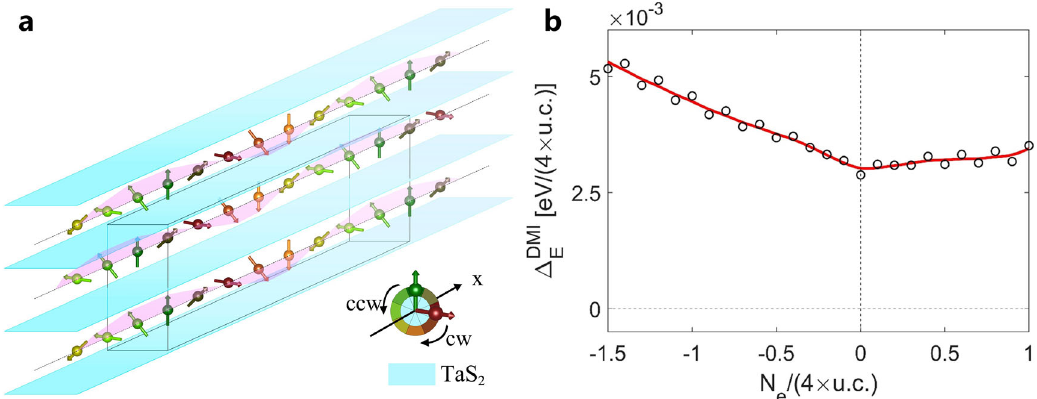
Fig. 4 DMI simulation in First-principles calculations. a Spin con fi gurations used to calculate DMI strength. Spins are represented by arrows. b The electron number N e -dependent DMI strength d ? ( / 4 DMI E ) for the supercell with four-spin cycle along one selected direction in ( a ). N e ¼ 0 represents the case of E F ¼ 0, and N e ¼ (cid:3) 1 : 5 ðþ 1 Þ represents the Fermi energy around (cid:3) 80meV ðþ 50meV Þ . The black circles are the results of First-principles calculation and the red line is fi tted from the black circles for